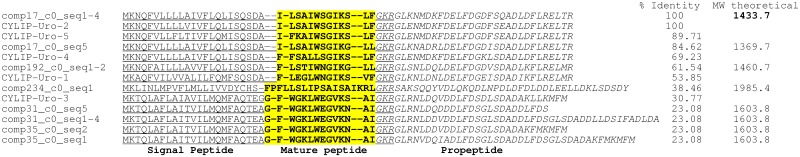
Sequence comparison of putative antimicrobial peptides from U. yaschenkoi and U. manicatus.Multiple alignment of sequences obtained from the transcriptome of U. yaschenkoi that codify antimicrobial peptides from the subfamily NDBP-5. These sequences are compared with CYLIP-Uro-1 (GenBank: GALI01000003.1), CYLIP-Uro-2 (GenBank: GALI01000004.1), CYLIP-Uro-3 (GenBank: GALI01000005.1), CYLIP-Uro-4 (GenBank: GALI01000006.1) and CYLIP-Uro-5 (GenBank: GALI01000007.1) from U. manicatus [49]. The predicted signal peptide is underlined; the mature peptide is in bold and highlighted in yellow, the conserved proteolytic site GKR is in italics and underlined and the propetide in italics. The hyphen (-) in the name of U. yaschenkoi sequences indicates that the amino acid sequence was found within different nucleotide sequences (transcripts), for example: comp17_c0_seq1-4 means that four different nucleotide sequences codify the same peptide. The percentage of identity of the mature peptide is indicated at the right (% Identity) with respect to the peptide encoded by comp17_c0_seq1-4; additionally, at the far right, the theoretical molecular weights of the antimicrobial peptides for U. yaschenkoi are shown. The theoretical molecular weight of the peptide encoded by the sequences comp17_c0_seq1-4 (in bold) has a perfect match with the U. yaschenkoi proteome previously reported by [41] at the retention time 13.88. Note: several sequences of transcripts found in the U. yaschenkoi transcriptome codify the same precursors, such as: comp17_c0_seq1-4 and comp18_c0_seq1-2 (not shown); comp17_c0_seq5 and comp18_c0_seq3-4 (not shown); comp192_c0_seq1-2, comp192_c0_seq4-5 (not shown), comp192_c0_seq7-9 (not shown) and comp196_c0_seq1-7 (not shown) codify the same precursor.